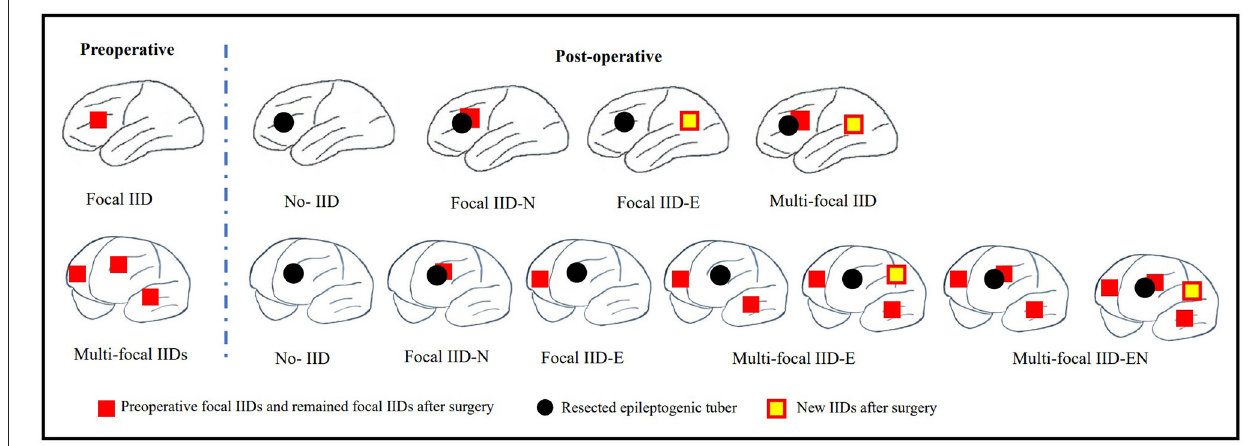
FIGURE 2 | Schematic diagram of pre-operative focal IID and multi-focal IID patterns and their post-operative IID patterns. The top row of this figure shows the pre-operative focal IID pattern and its post-operative patterns, including non-IID, focal IID-N (continuous IID located near the resected region), focal IID-E (new IID located elsewhere to the resected region), and multifocal IID-EN (new IID located elsewhere to the resected region and continuous IID located near the resected region). The bottom row of this figure shows the pre-operative multiple focal IID pattern and its post-operative patterns, including non-IID, focal IID-N, focal IID-E (continuous IID located elsewhere to resected region), multifocal IID-E (continuous IID or continuous IID and new IID located elsewhere to regions with pre-operative IIDs), multi-focal IID-EN (continuous IID or new IID located elsewhere to regions with pre-operative IID, and continuous IID located near the resected